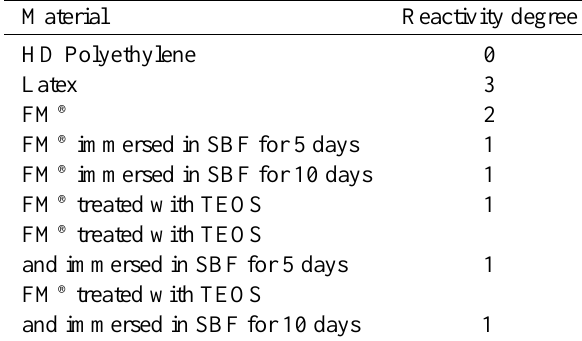
Table 1. Fiber Max (FM ® ) cytotoxicity determined by Elution Test USP-23.